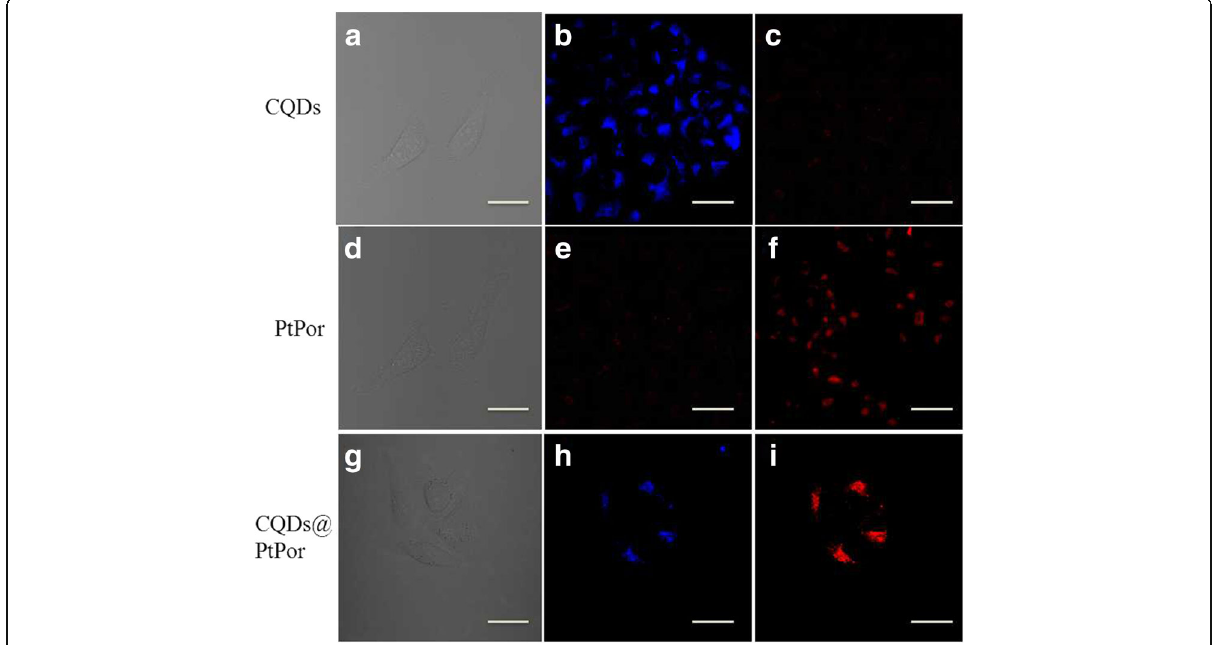
Fig. 7 The confocal fluorescence microscopy images of HeLa cells under 405 nm excitation after treatment with 50 μ g/mL of pure CQDs ( a – c ), PtPor ( d – f ), and CQDs@PtPor ( g – i ) for 24 h. a , d , g Bright field. b , e , h The CQDs imaging channel, detected at the wavelength region of 410 – 450 nm. c , f , i The PtPor imaging channel, detected with the 590 nm long pass region; (scale bar = 20 μ m)